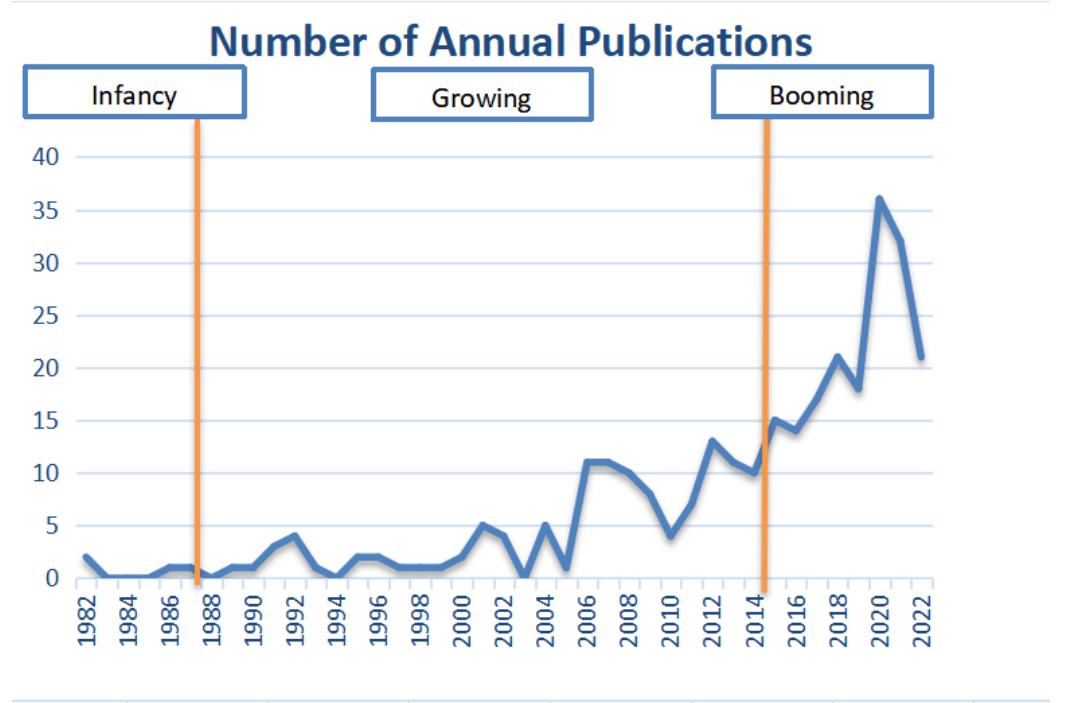
Figure 1. Annual Publication statistics of TECC during 1982–2022.